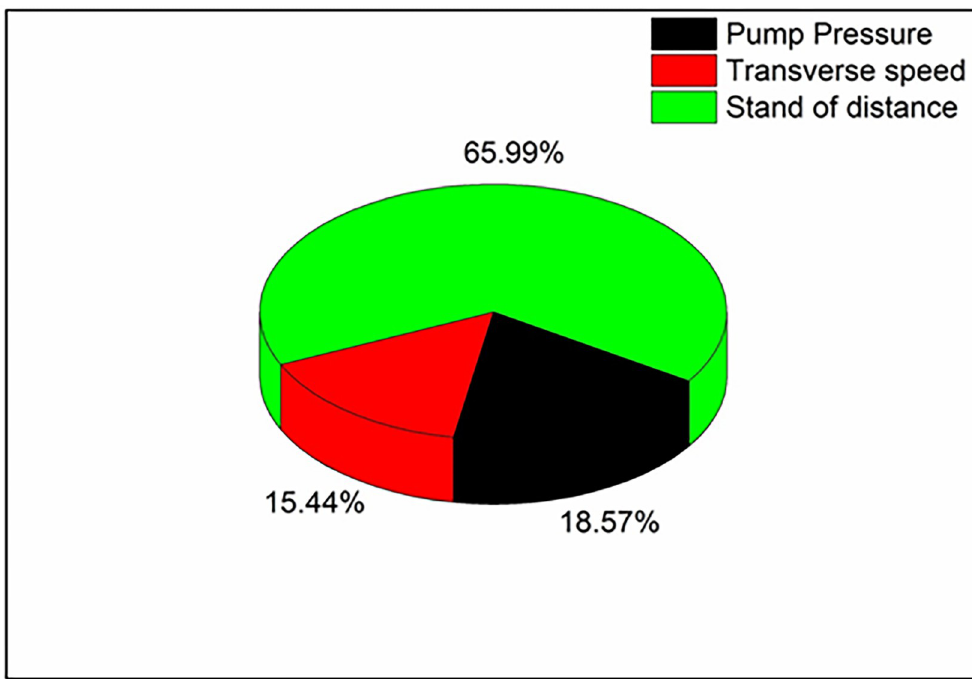
Fig 8. Contribution of machining parameters in 0.1 wt. % filler loaded